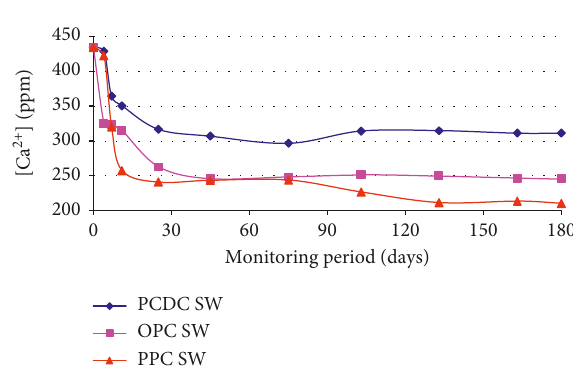
Figure 22: Na + analyses in sea water.